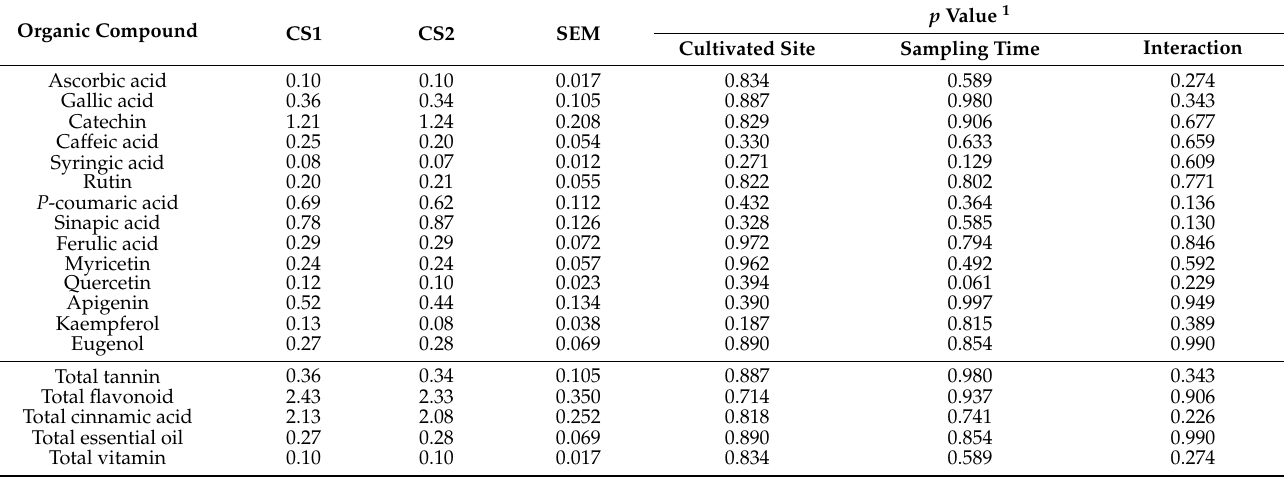
Table 2. Total contents (mg/g on a dry weight basis) of tannin, flavonoid, cinnamic acid, essential oil, and vitamin in Farang ( P. guajava L.) leaves harvested from various cultivation sites over a five-month